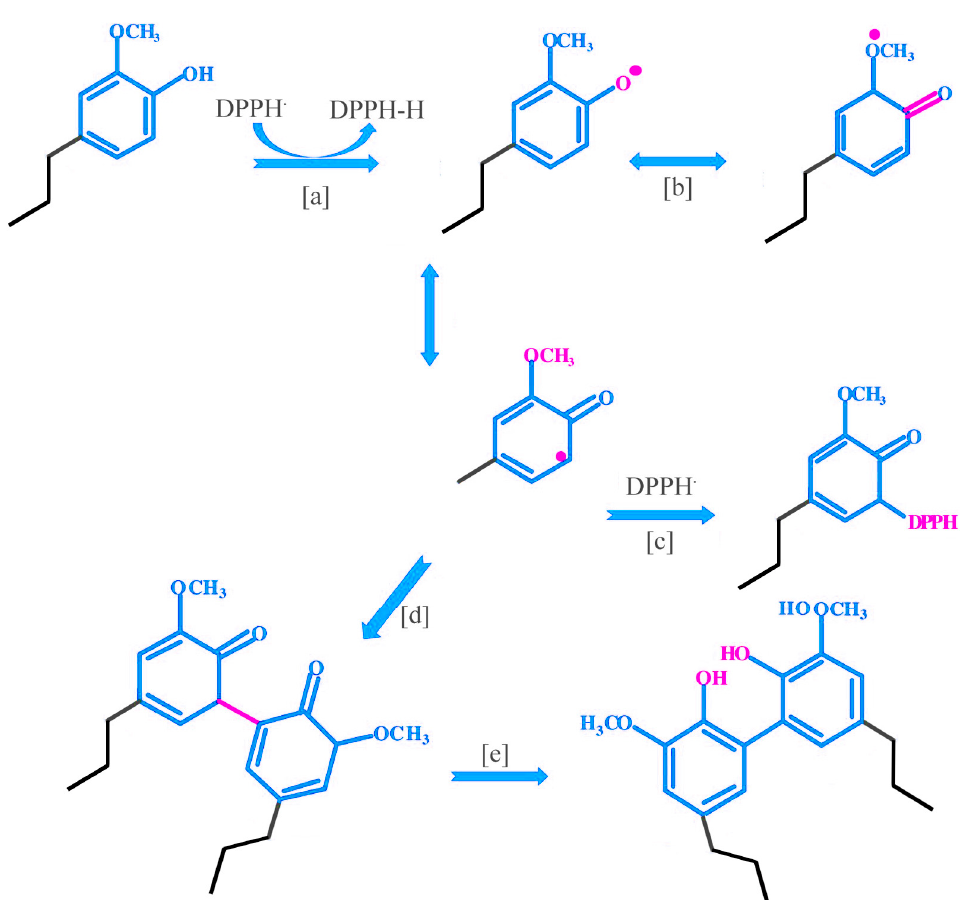
Figure 4. Possible routes of antioxidant reactions of a lignin model substance (2-methoxy-4- propylphenol) in DPPH solution.